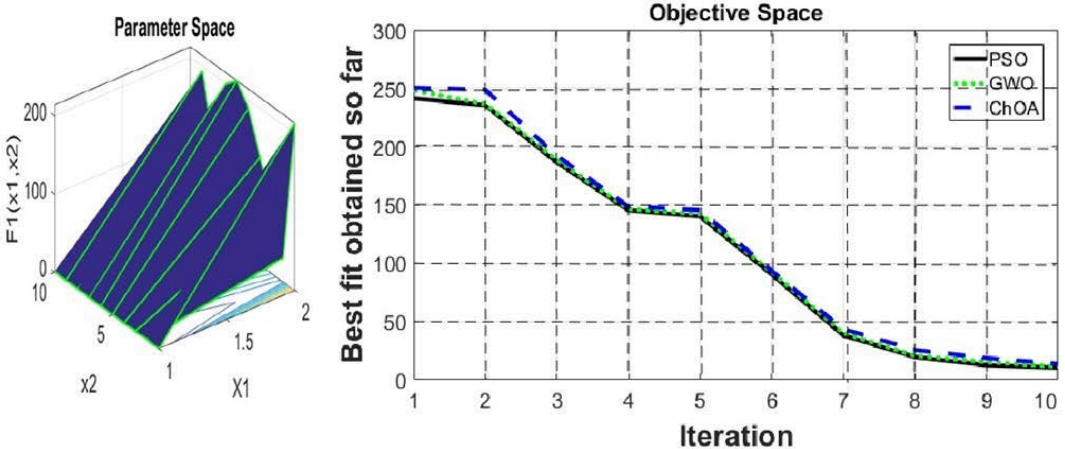
Figure 15. Convergence curves of different algorithms for MPPT under shading pattern of 800 W/m 2 , 600 W/m 2 , 400 W/m 2 , and 200 W/m 2 .